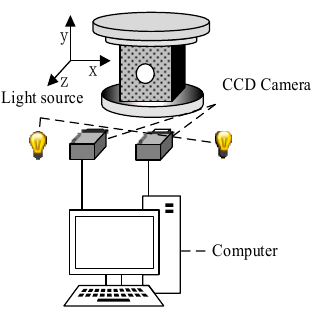
Figure 1. System structure. CCD: charge-colored device.